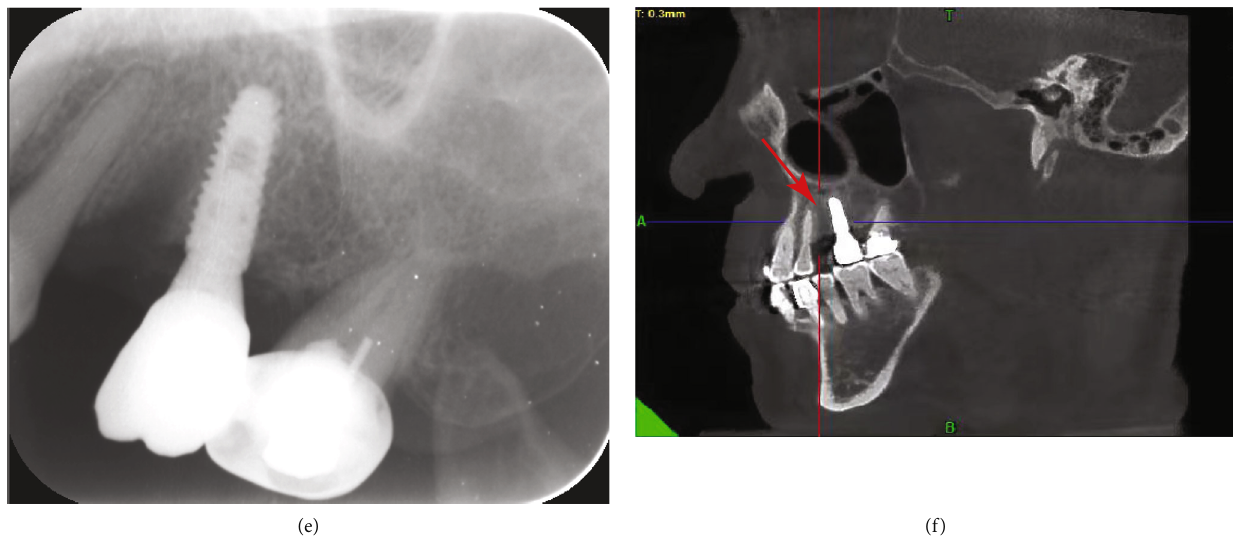
Figure 1: Case 1: (a) Preliminary photograph showed a defect of the palatal crown to the subgingival at tooth #25. (b) The original Cone- beam CT. (c) The apical radiograph revealed the insu ffi cient distance between tooth #25 and the implant. (d) The coronal radiograph clearly showed that the apical lesion of tooth #25 destroyed the peri-implant bone (red arrow). (e) Three months after extraction. (f) Intraoral radiography one year after extraction (red arrow).